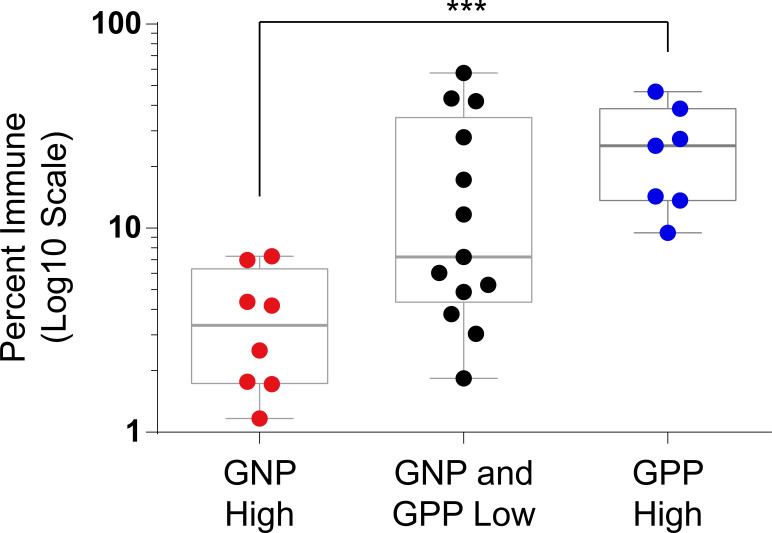
Abundance of immune cells correlated with the abundance of prognostic cell subsets.Box and whisker plot of immune abundance (%, log10 scale) on the y-axis and patients divided into three groups: GNP high (red,>2.96% GNP cells), GPP high (blue,>8.65% GPP), or GNP and GPP low (gray). Box encompasses the 25th to 75th percentile, gray horizontal line indicates the median, and whiskers extend to the minimum and maximum values. ***p=0.0008, two-tailed t-test.